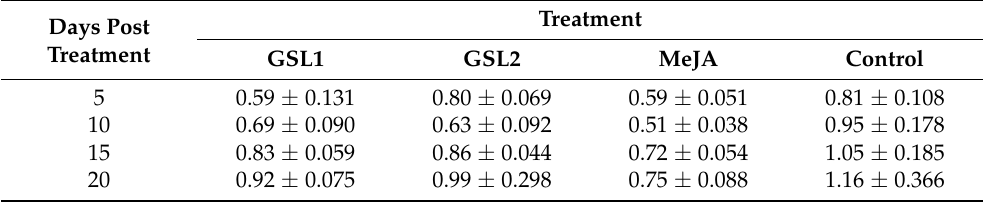
Table 2. Relative fraction of viable A. malaccensis callus cells treated with elicitors derived from F. solani strain GSL1 or GSL2 mycelium, or MeJA on day 5, 10, 15, and 20 compared to callus cells